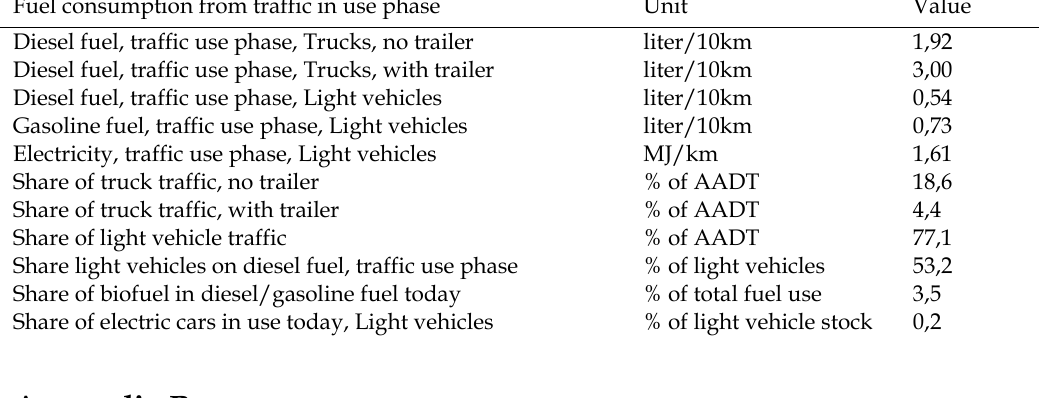
Table A. Traffic mixes and average fuel consumption of vehicles assumed in LICCER model Fuel consumption from traffic in use phase Unit